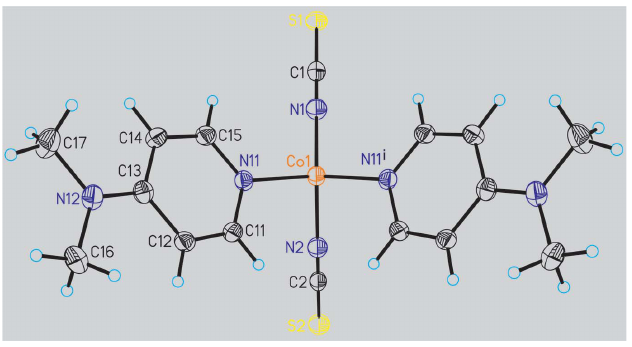
Figure 1 Crystal structure of form I with labeling and displacement ellipsoids drawn at the 50% probability level. Symmetry code: (i) = x , 3/2 (cid:3) y, z